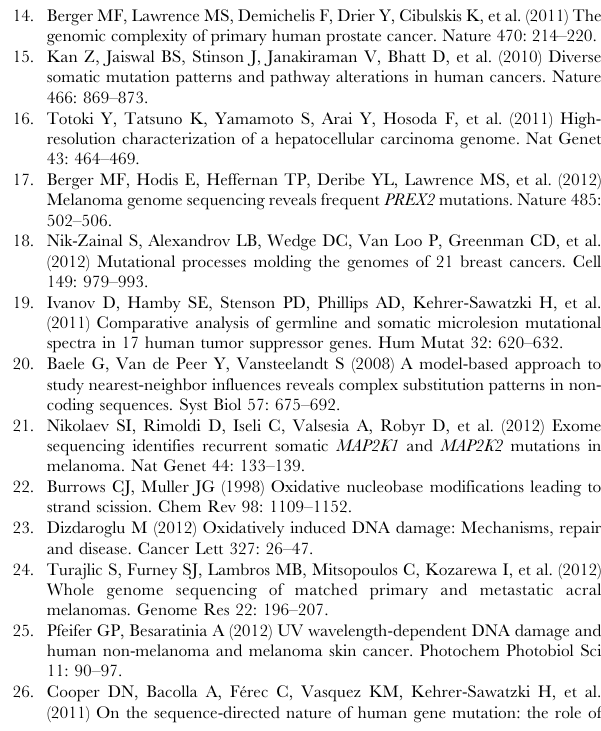
Table S7 Correlations with free energy of base stacking and VIPs. Panel A , correlations of ln [ f (DGNN)] values with free energies of base stacking; Panel B , correlations of ln [ f (DGN)] values with VIPs. For the combined datasets, the fractions were normalized. f i values were computed using the Duke35 (GWS) and AgilentV2 (EWS) mappability counts. Table S8 Fractional representation of genes with NS substitu- tions across cancer tissue types and their Aggregate Score. List of genes found to contain non-synonymous substitutions and their combined fractional representation, expressed as Aggregate Score, across cancer types. Table S9 Recurrent NS substitutions and driver mutations. Hg19 coordinates containing the largest number of recurrent NS substitutions for various types of motifs and their potential as driver mutations; 1 sequences are reported with the mutated base (A or G) at P2; 2 support from PubMed for a driver mutation following searches for ‘‘gene_name & mutated_codon’’ or ‘‘gene_name & cancer’’ and a manual review of the articles found: *** mutated codon that has been reported as a driver mutation; ** (!) mutated codon in p53 that has not been reported to harbor a driver mutation; ** strong support for gene mutation or change in gene expression being involved in tumorigenesis; * weak support for gene mutation or change in gene expression